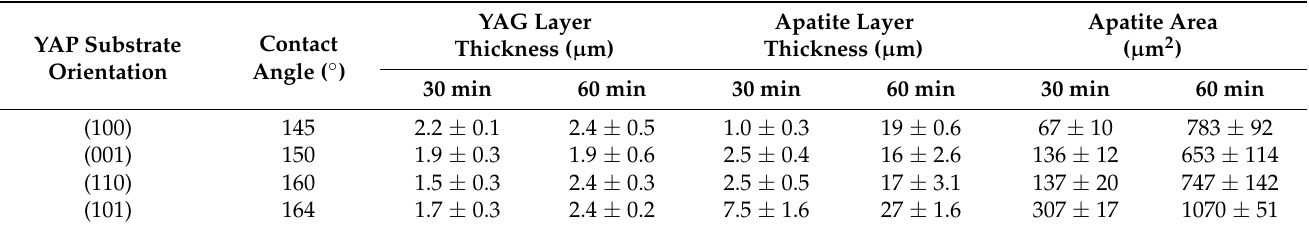
Figure 1. Representative cross-sectional SE micrographs of the YAP/CMAS reaction at ( a ) 1 min, ( b ) 10 min and ( c ) 30 min at 1350 ◦ C. The YAP substrate is the (101) orientation and is representative of all substrate orientations. Table 2. Measurements of the YAP/CMAS contact angle and various attributes of the reaction phases for the four YAP orientations at different exposure times at 1350 ◦